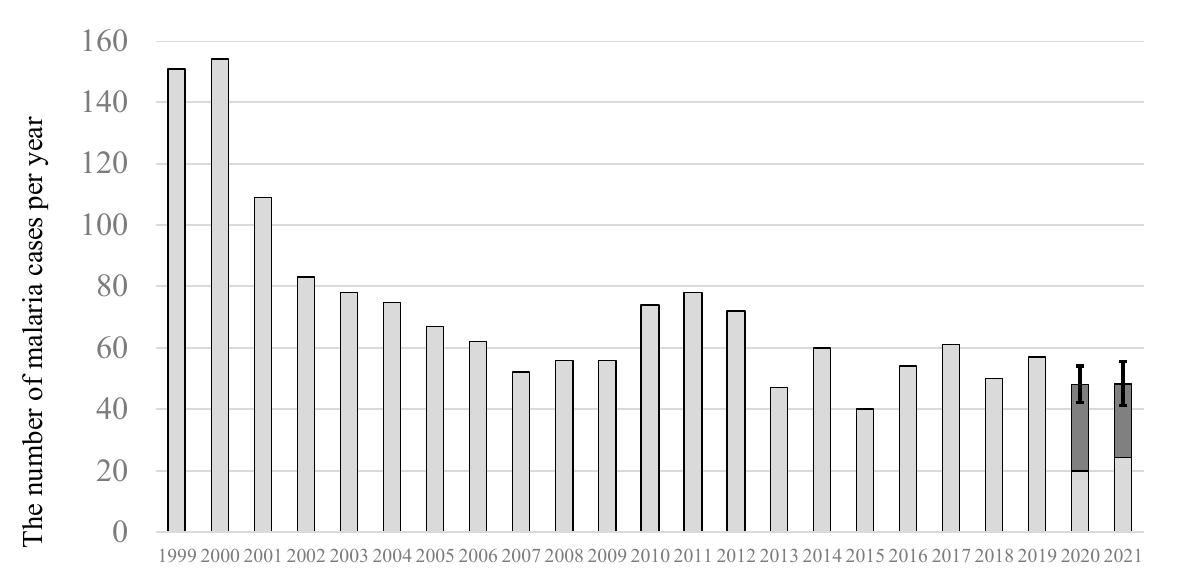
Figure 2. Secular trend in the actual number and the potentially reduced number of malaria cases in Japan. The error bars show 95% confidence limits of the number of potentially reduced malaria cases per yar.